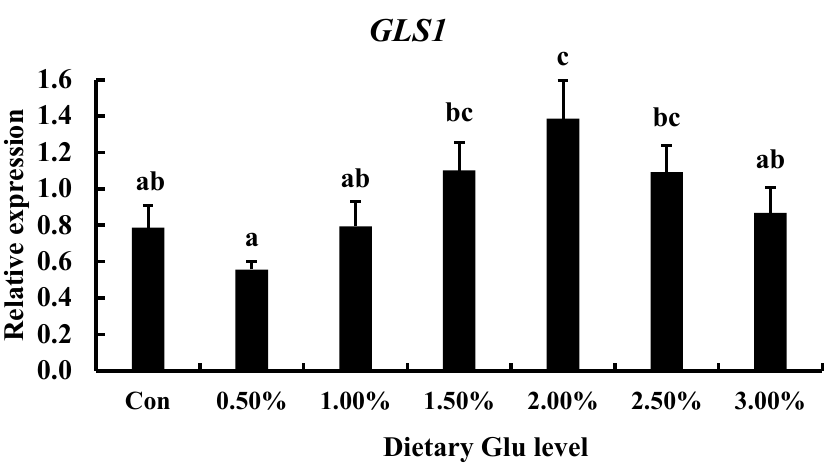
Figure 8. TCC gls1 gene expression with different supplemental glutamate (mean ± SE of relative expression; n = 9). Different letters represent significant difference ( p < 0.05).